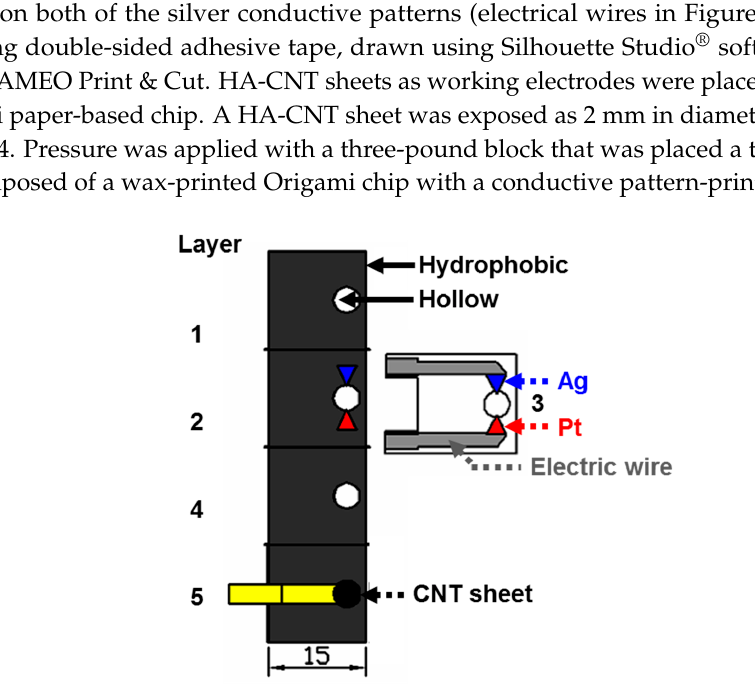
Figure 2. Basic design of the paper-based electroanalytical device.